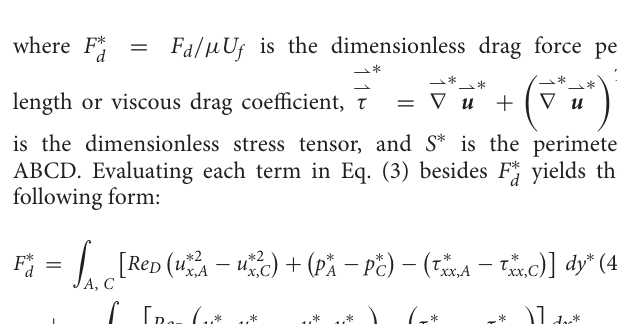
FIGURE 2 | (A) shows a schematic depicting the stationary drop (gray circle) with diameter D d , density ρ f and dynamic viscosity µ d , subjected to a flow with upstream velocity U f , density ρ f , and dynamic viscosity µ f . In (B) a control region ABCD is drawn around the drop where the positive x -direction is in the flow direction.